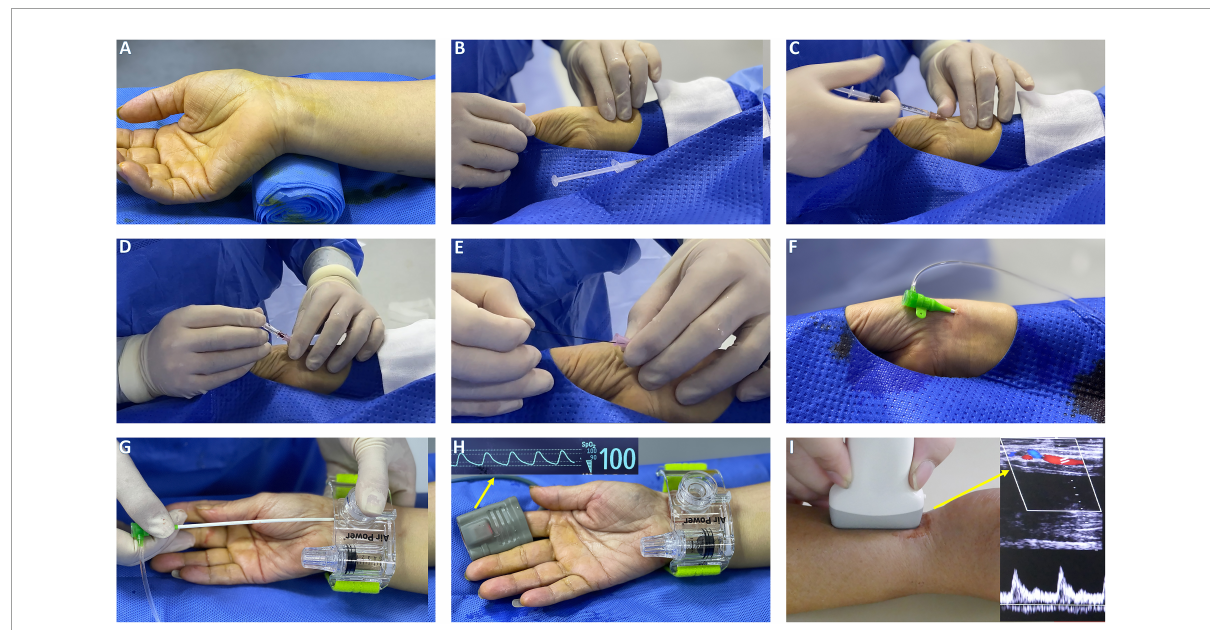
FIGURE2 The procedure setup of TRA. (A) Hand position for radial artery puncture and rolled up towel under the dorsal wrist. (B) Palpation of radial artery with fingers. (C) Local anesthesia with lidocaine. (D) Puncture TRA with 20 G plastic cannula. (E) Mini guidewire advancement. (F) Radial artery sheath insertion. (G) An air power device is placed over the puncture site with the sheath retracted. (H) Sheath removal while rotating pneumatic screw until hemostasis was achieved. (I) Evaluation of radial patency by Doppler ultrasound.